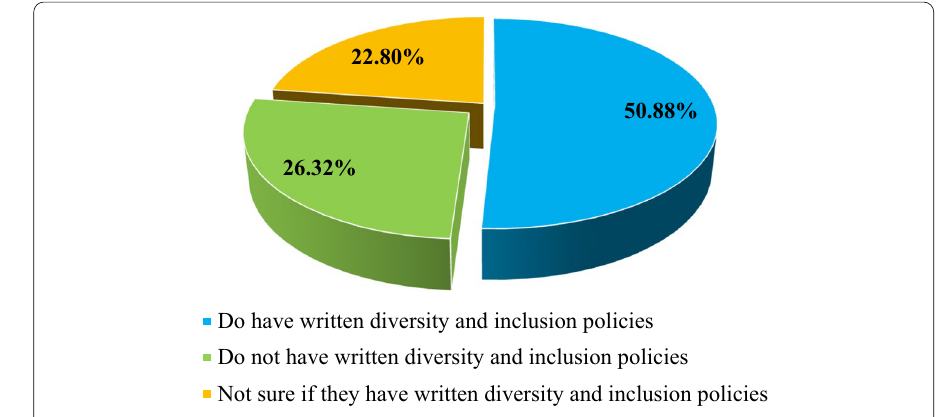
Fig. 27 Presence of written diversity and inclusion policies